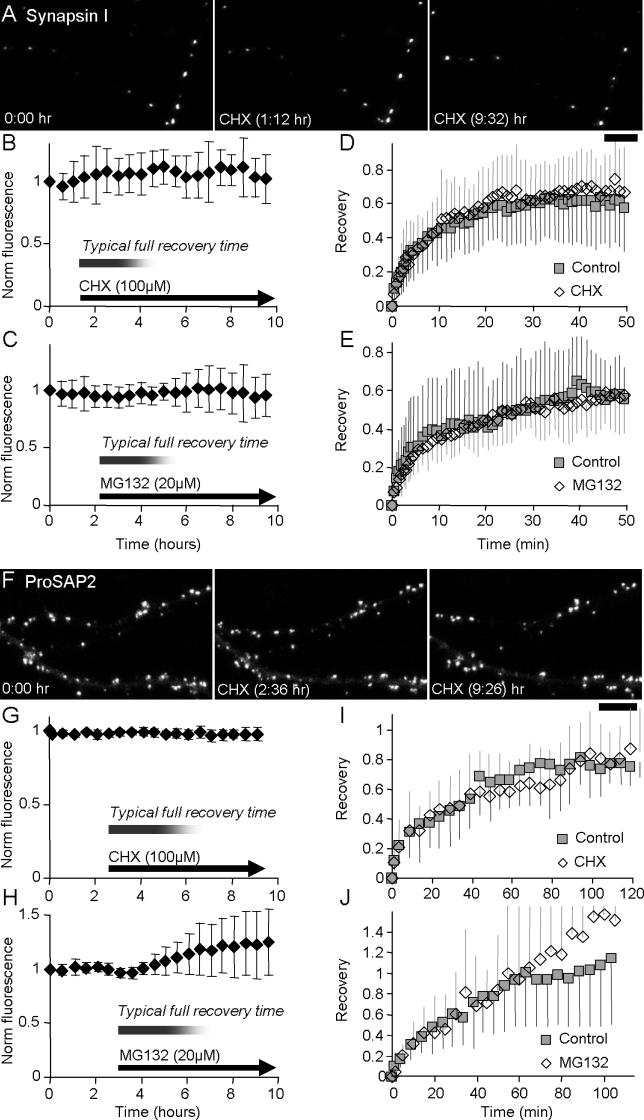
Effects of Cycloheximide and MG132 on Steady State Levels and Exchange Rates of GFP:Synapsin I and GFP:ProSAP2(A) Long-term imaging of axons of neurons expressing GFP:Synapsin I, before and after the addition of cycloheximide (CHX). CHX was added to attain a final concentration of 100 μM 1 h 12 min after the beginning of the experiment.(B) Mean fluorescence levels of all GFP:Synapsin puncta recorded in this experiment normalized to their mean fluorescence intensities at the beginning of the experiment (five cells, 13 fields of view, 197 synaptic boutons).(C) A similar experiment in which MG132 was added 2 h 29 min after the beginning of the experiment to attain a final concentration of 20 μM. Fluorescence levels were normalized to fluorescence intensities at the beginning of the experiment (four cells, ten fields of view, 225 synaptic boutons).(D) Paired FRAP experiments were performed in the same preparations of neurons expressing GFP:Synapsin I, first in the absence and then in the presence of cycloheximide (three experiments, 12 boutons before cycloheximide addition, 11 boutons after cycloheximide addition).(E) Paired FRAP experiments as in (D) but with MG132 instead of cycloheximide (four experiments, 13 boutons before MG132 addition, 16 boutons after MG132 addition). All experiments in (A–E) were performed in CNQX and AP-5 to avoid the confounding effects of spontaneous activity.(F) Long-term imaging of dendrites of neurons expressing GFP:ProSAP2, before and after the addition of cycloheximide (at 2 h 36 min after the beginning of the experiment).(G) Mean fluorescence levels of all GFP:ProSAP2 puncta recorded in this experiment normalized to their mean fluorescence intensities at the beginning of the experiment (five cells, five fields of view, 678 PSDs).(H) A similar experiment in which MG132 was added 3 h 4 min after the beginning of the experiment (seven cells, eight fields of view, 574 PSDs).(I) Paired FRAP experiments were performed in neurons expressing GFP:ProSAP2, first in the absence and then in the presence of cycloheximide (three experiments, ten PSDs before cycloheximide addition, eight PSDs after cycloheximide addition).(J) Paired FRAP experiments as in (I) but with MG132 instead of cycloheximide (three experiments, nine PSDs before MG132 addition, nine PSDs after MG132 addition). Data in FRAP experiments were not corrected for photobleaching during the recovery phase to avoid canceling out general changes in puncta fluorescence related to cycloheximide or MG132 addition. For sake of clarity, only one-sided error bars are shown in (D, E, I, J). Bars (A, F), 10 μm.